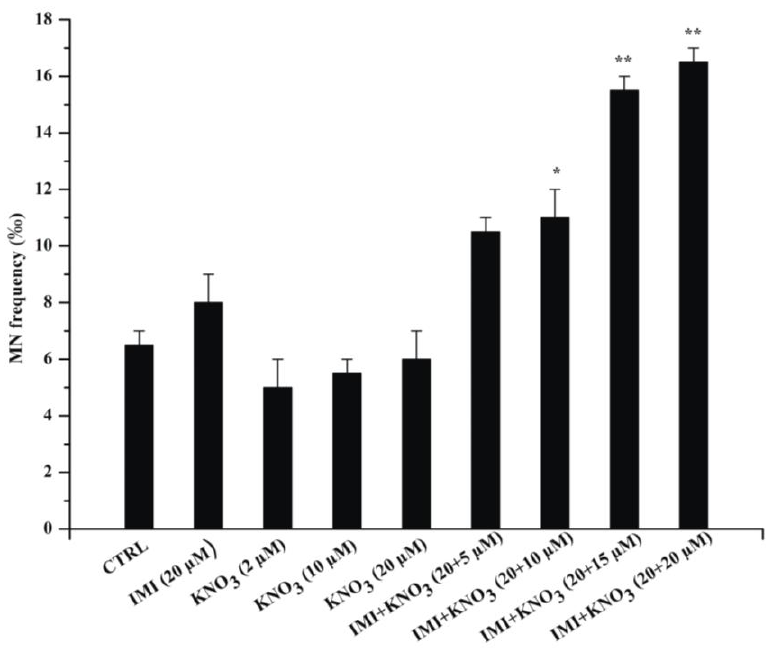
FIGURE 3. Effects of imidacloprid (IMI) and KNO 3 as pure compounds, and as mixtures on MN frequency (mean ± standard error) in cytokinesis-blocked human peripheral lymphocytes. * = p < 0.05, ** = p < 0.01 (significant differences between control [CTRL] and treated cultures by